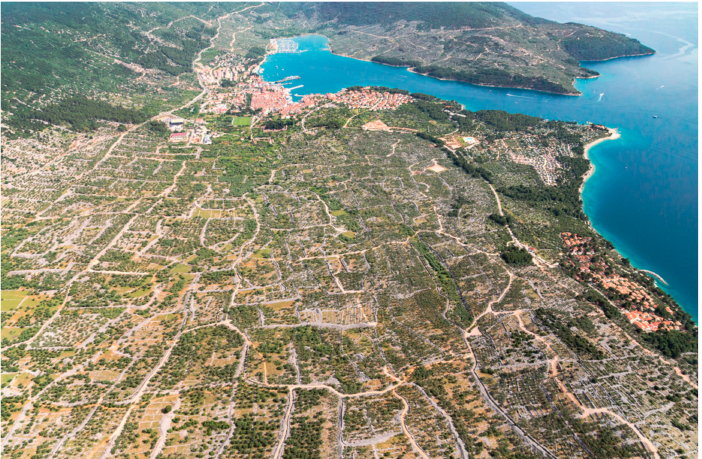
Figure 1. Olive groves and the amphitheatrical karst valley surrounding the town and bay of Cres (Goran Andlar,